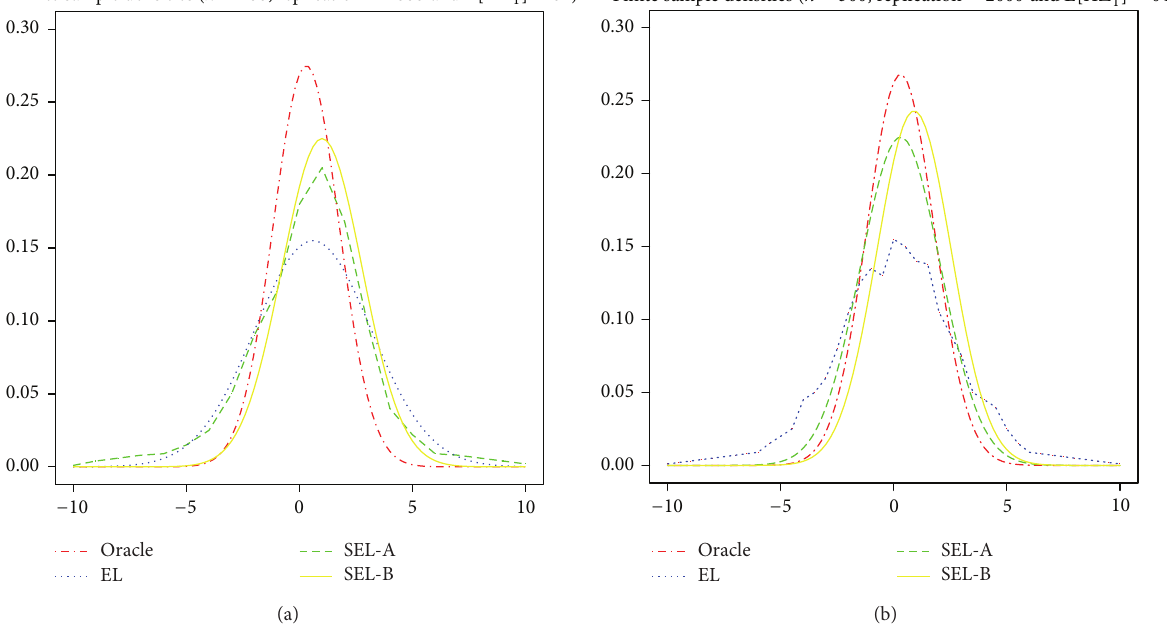
Figure 1: Finite sample densities of EL and EL shrinkage estimators for 𝜃 2,0 in the cases of example (1). The SCAD penalty is used in the EL shrinkage estimation and the first-step estimators of moment selection coefficients are the EL estimators; (2) oracle estimators are the EL estimators using the moment conditions in set-1 and all correct moment conditions in set-2; (3) EL estimators only use the moment conditions in set-1; (4) SEL-A refers to the EL shrinkage estimators using tuning parameters selected by minimizing EmAIC; (5) SEL-B refers to the EL shrinkage estimators using tuning parameters selected by minimizing EmBIC.